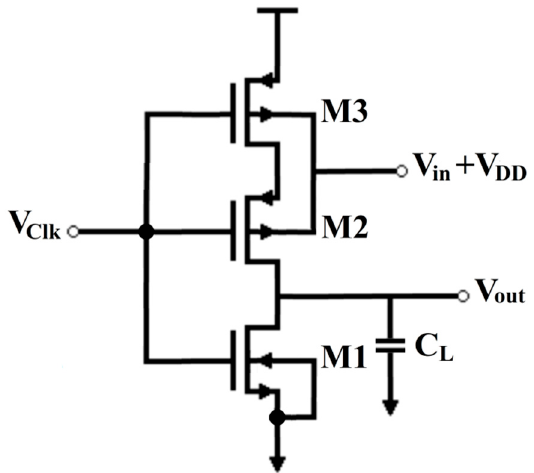
Figure 5. Second proposed VTC circuit.